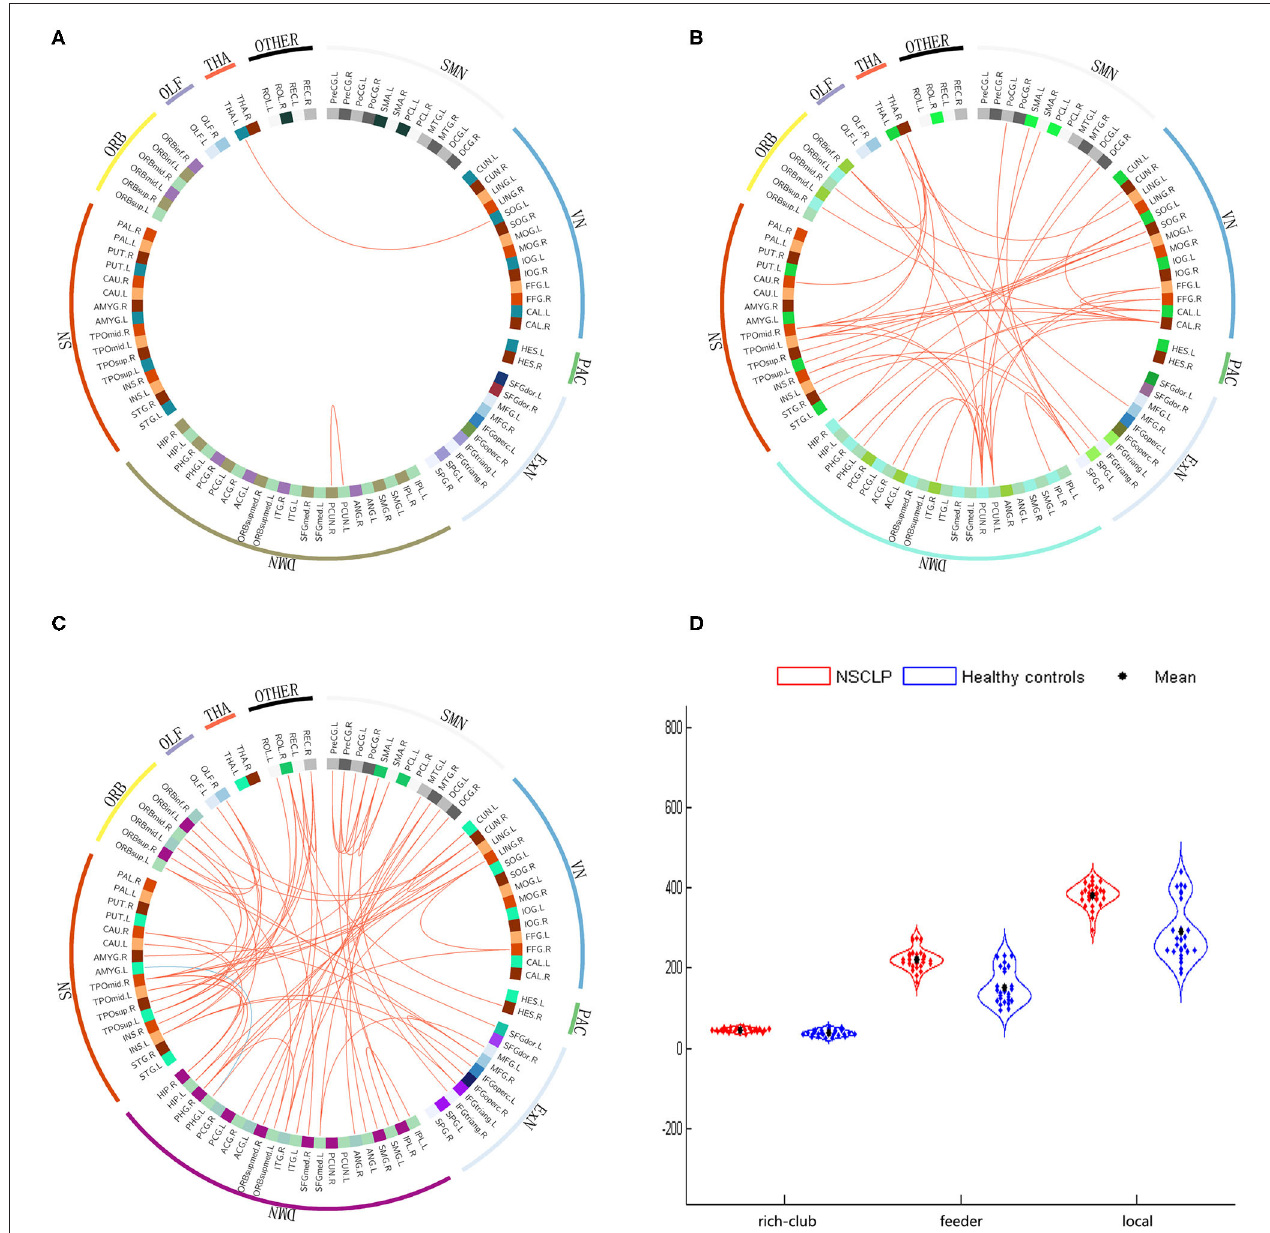
FIGURE 4 | (A–C) : The different connections in the NSCLP group relative to healthy comparison. (A) : rich-club connections, (B) : feeder connections, (C) : local connections. Red edges indicate higher connectivity strength in the NSCLP group than in healthy comparison, and blue edges indicate lower connectivity strength. (D) : significantly altered between-group connectivity strength illustrated by rich-club, feeder, and local connections. SMN, sensorimotor network; VN, visual network; Exner, external frontoparietal network; DMN, default mode network; SN, salience network; ORB, orbitofrontal cortex; PAC, primary auditory cortex; TAH, thalamus; OLF, olfactory